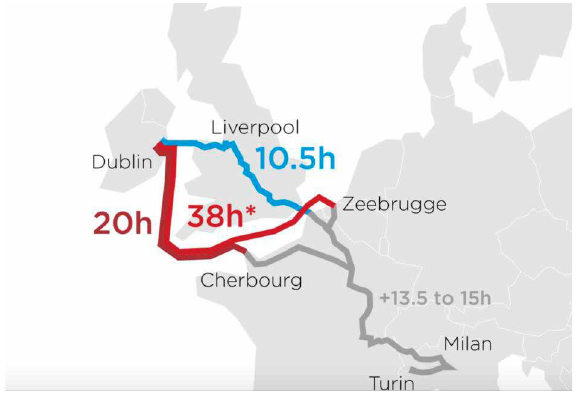
Figure 1: Alternative freight routes